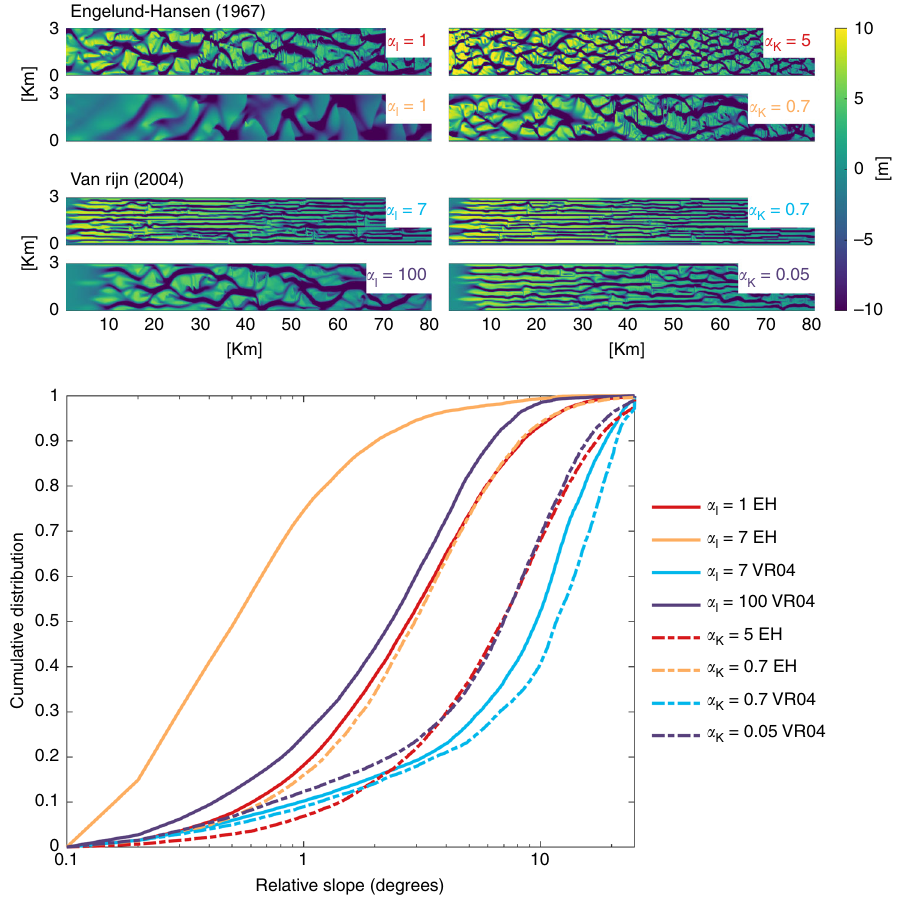
Fig. 4 In fl uence of slope effect and transport predictor on morphology. Morphology of eight braided river model runs for different combinations of slope effect and sediment transport predictors. Models on the horizontal axis have equal slope effect. The α while the α is the input parameter of the method of Koch and Flokstra 28 , both with defaults of order 1. The graph shows the cumulative distribution of the K slopes of all grid cells in the same models at the same timestep. Solid lines are results with IK and dashed lines are results with KF. Colors indicate equal transverse sediment transport magnitudes and the same sediment transport